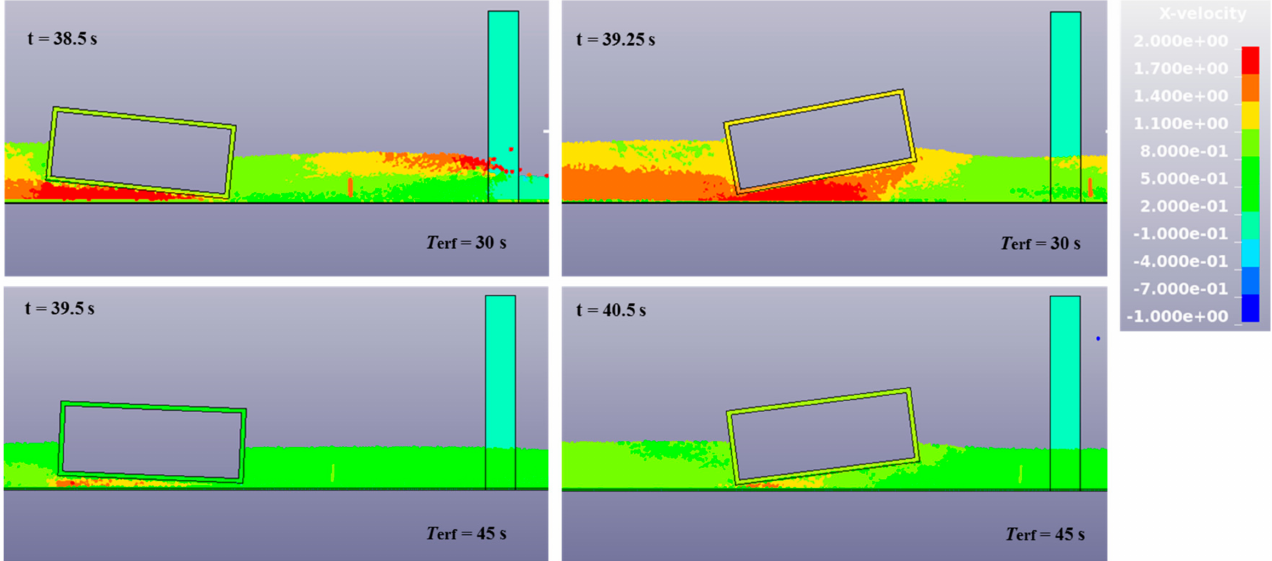
Figure 13. Snapshots of debris − tsunami interaction and impact on the column. Numerical results for h 1 = 2.496 m and two wave cases with T erf = 30 s ( top ) and 45 s ( bottom